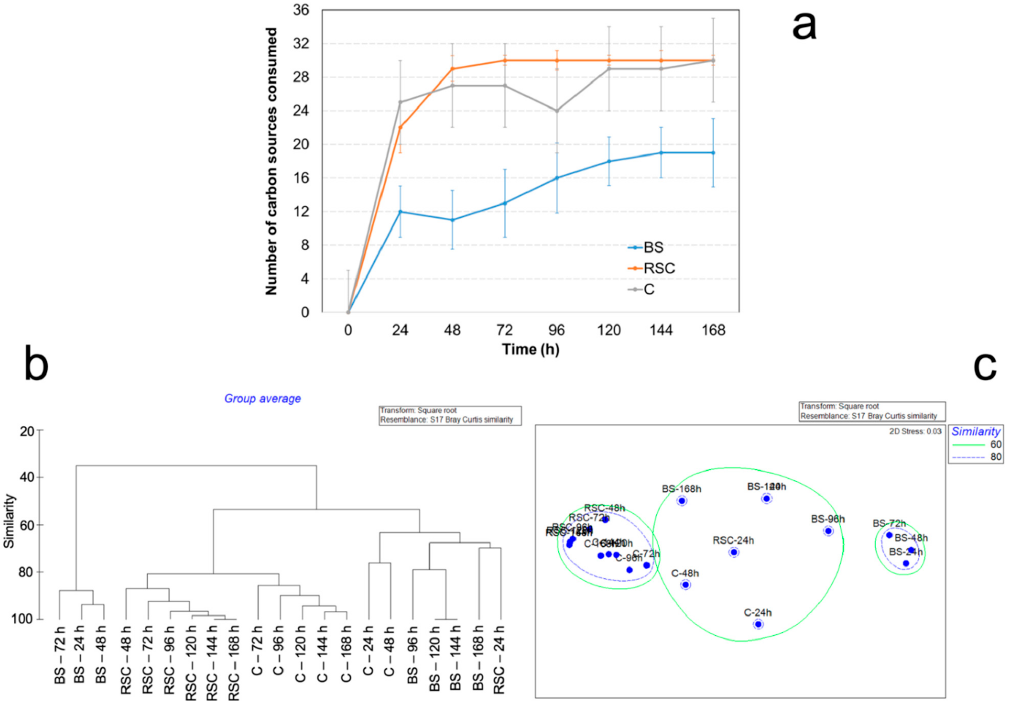
Figure 3. Physiological profiles of total microbial community determined by community–level physiological profile (CLPP). ( a ) Number of carbon sources consumed in samples of compost (C), rhizosphere soil with compost application (RSC) and bulk soil (BS) in Biolog EcoPlates TM after incubation at 25 ◦ C in the dark for one week (168 h). Error bars denote standard deviation ( n = 3). Dendrogram ( b ) and non-metric multidimensional scaling ( c ) based on CLPP